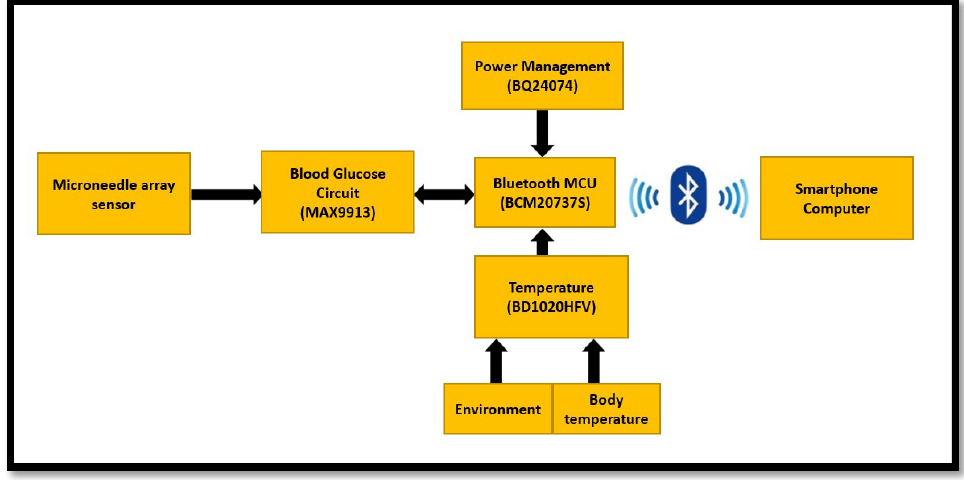
Figure 2. CGMS System Concept of